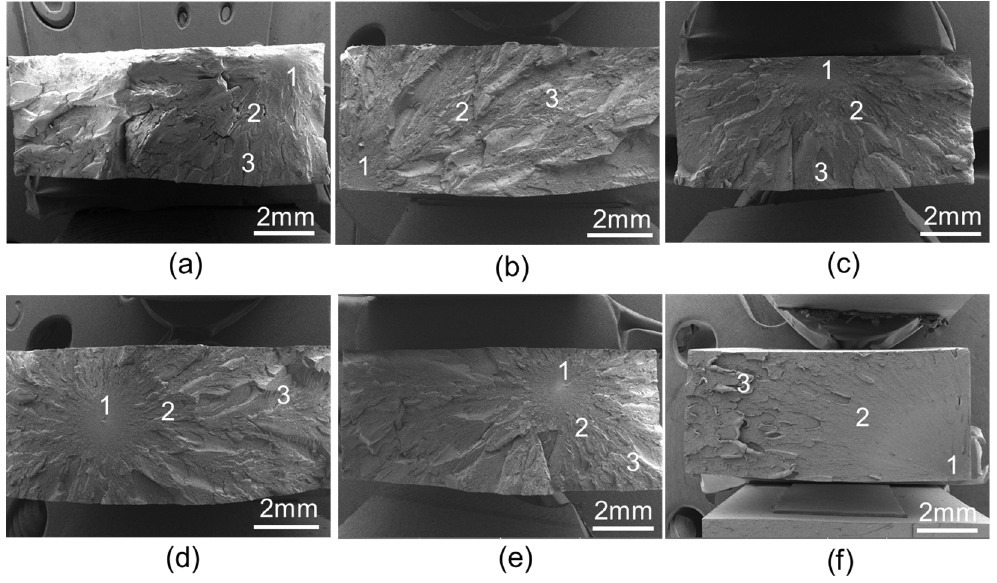
Figure 3. Micrographs of taken from the fractured surface of the aged samples. ( a ) GF/PEI-0, ( b ) GF/PEI-85, ( c ) GF/PEI-100, ( d ) GF/PEI-115, ( e ) GF/PEI-130, ( f )